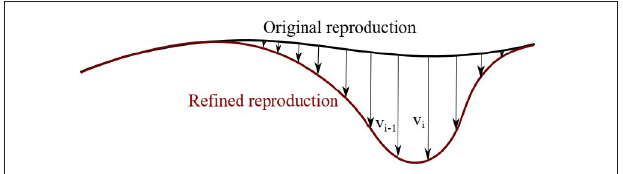
FIGURE 13 | Formation of the refinement matrix from the original and modified